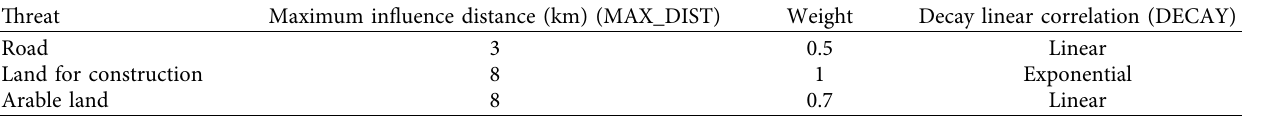
Table 4: Threat factor attribute table.